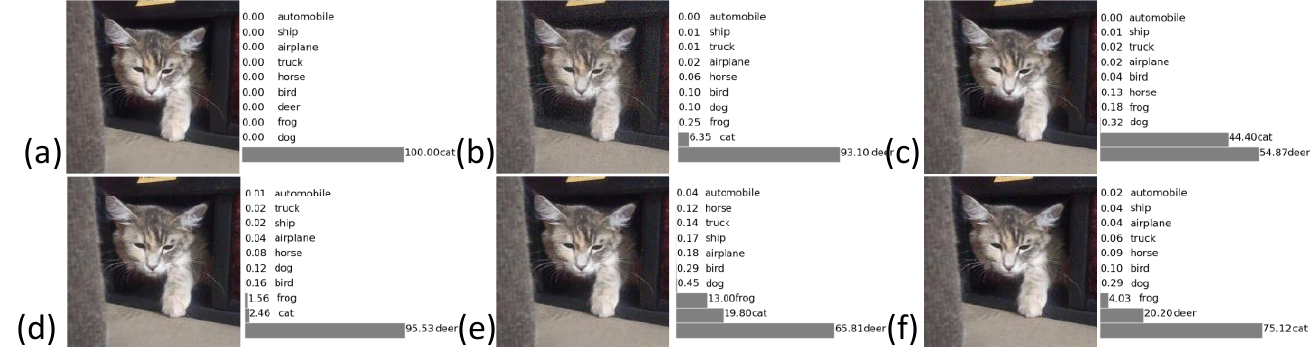
Figure 6. Results of image “ Cat_ Maine_Coon ” recognition: ( a ) original image; ( b ) image noisy with random-valued impulse noise of intensity 10%; ( c ) image cleaned by the method [28]; ( d ) image cleaned by the method [25]; ( e ) image cleaned by the method [27]; ( f ) image cleaned by the proposed method.